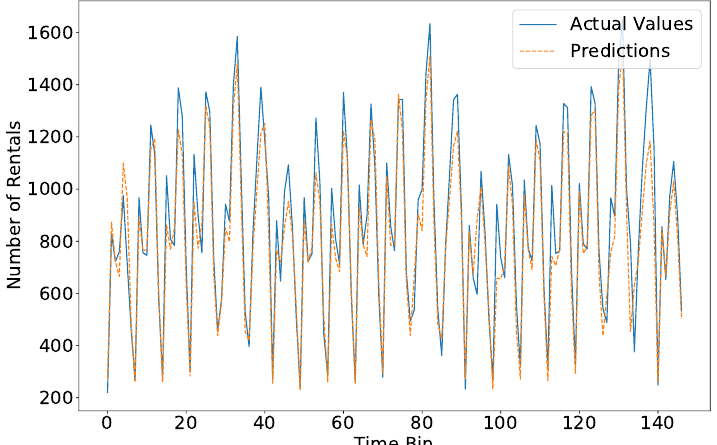
Figure 9. Short-term temporal prediction—Performance of the RFR model with expanding window in the validation set (24